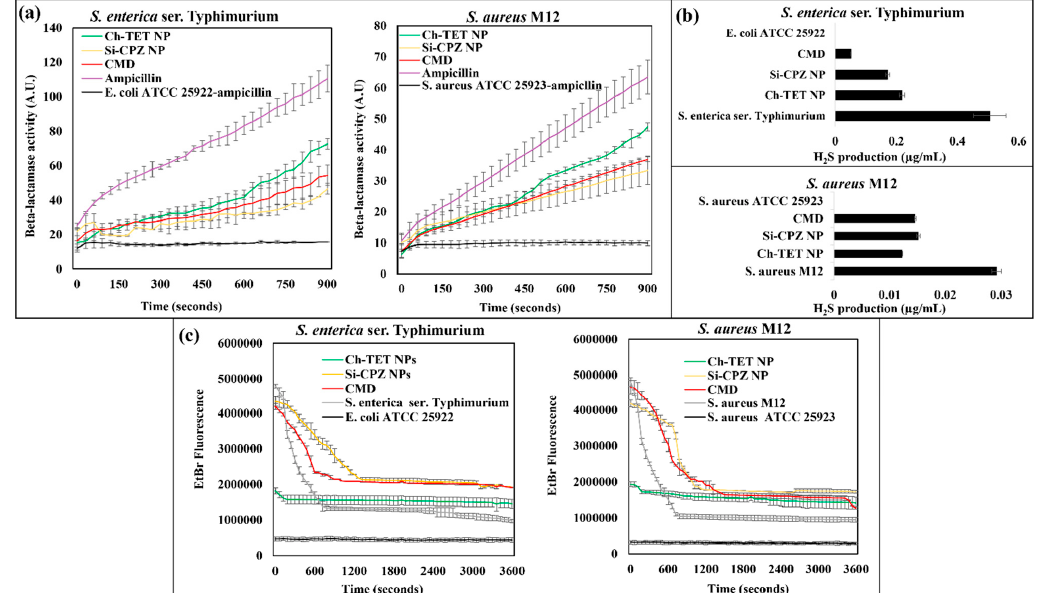
Figure 4. Effect of synthesized nanoparticles on resistance mechanisms. ( a ) Inhibition of beta-lactamase enzyme in bacteria treated with synthesized nanoparticles measured using nitrocefin assay, ( b ) H 2 S production of bacterial strains was measured after treatment with synthesized particles, and ( c ) EtBr extrusion (efflux) from bacterial cells after treatment with nanoparticle treatments was determined by measuring fluorescence.